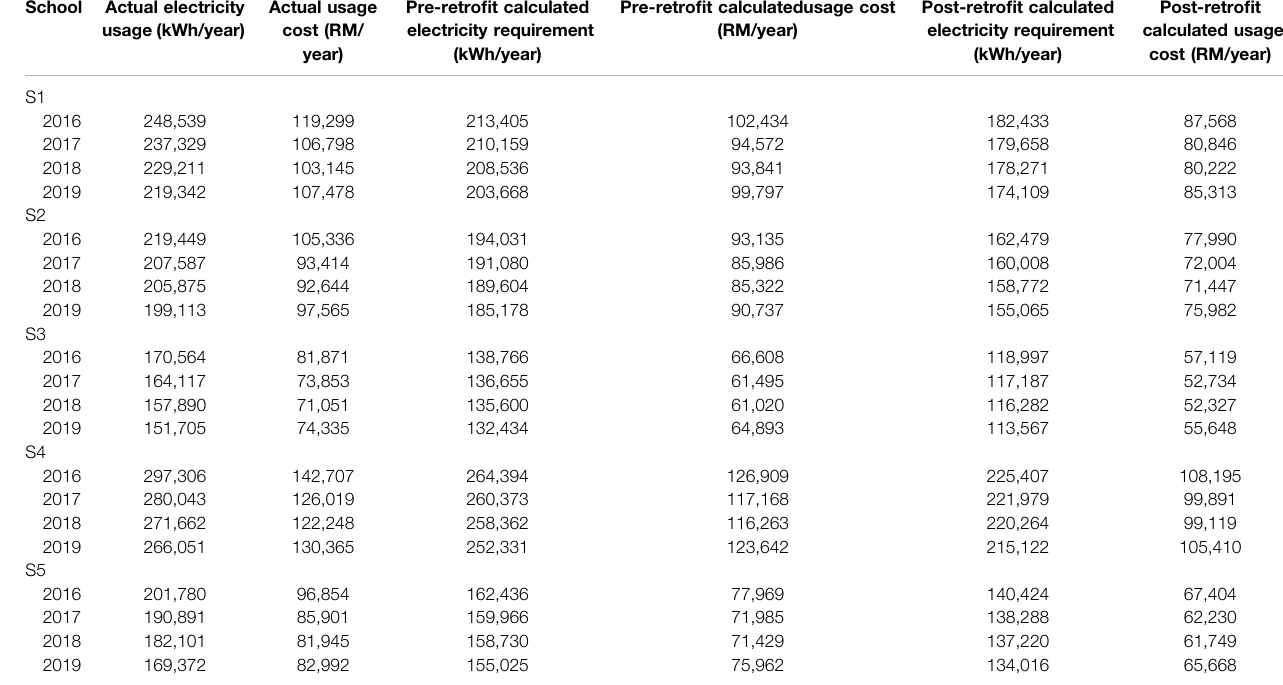
TABLE 4 | Summary of yearly energy usage from utility bills, pre-retro fi t calculated energy requirement, and post-retro fi t calculated energy requirement. School Actual electricity Actual usage usage (kWh/year) cost